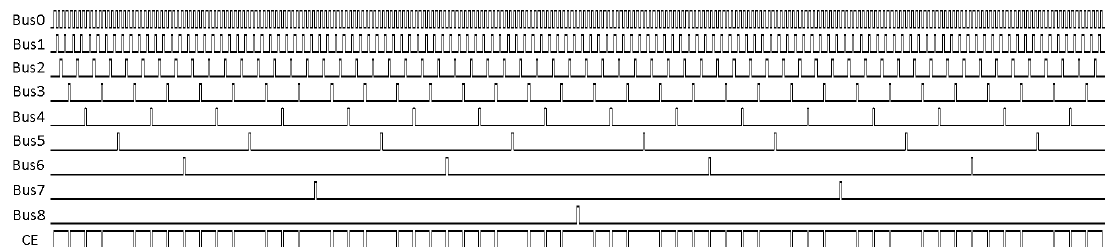
Figure 4. The timing diagram for the Bus(0)–Bus(8) with the gain correction only. The last waveform shows the clock enable (CE) signal (gain correction coefficient: 459/511). For better readability, the constant pixel clock frequency is assumed.